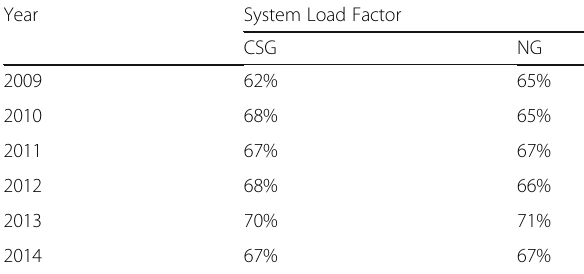
Table 6 Load factor of CSG and NG